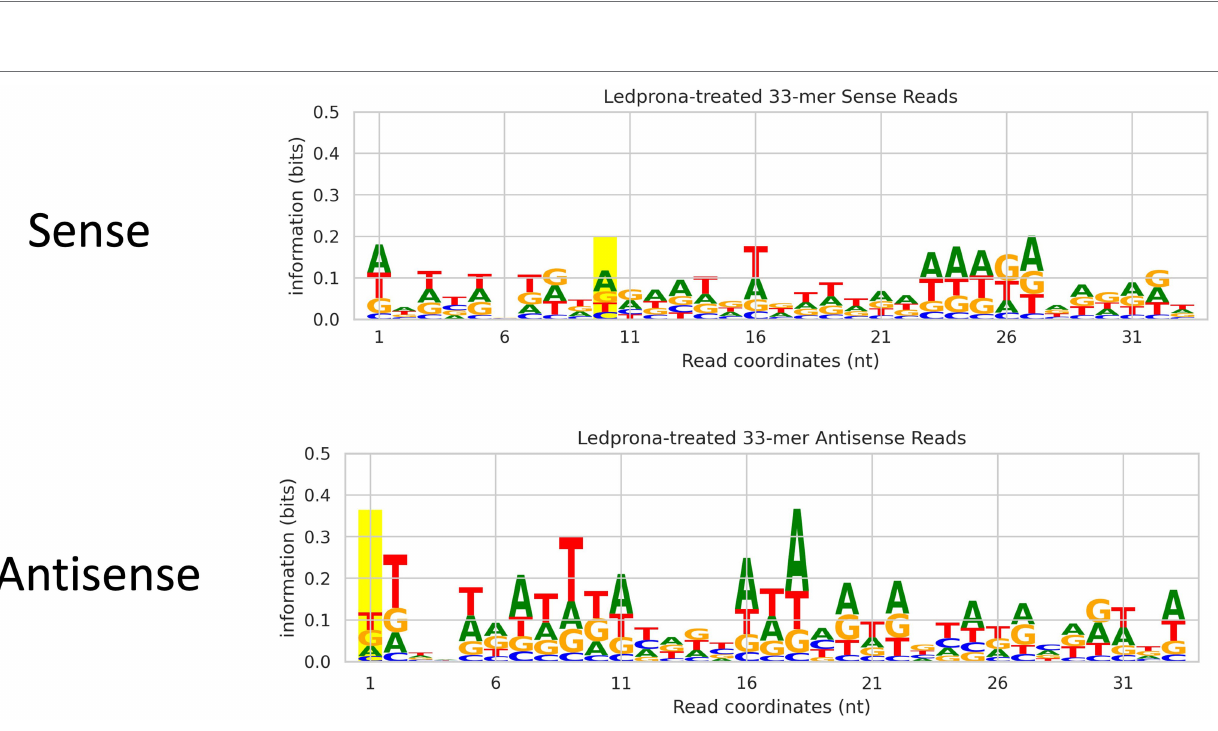
FIGURE 4 | Sequence logo image of 33 nt sequences produced in response to Ledprona treatment to check for ping-pong-derived piRNAs. The top panel shows the sense sequence, and the bottom panel shows the antisense. Position 1 and 10 are highlighted. Y-axis is amount of information (and thus, confidence) for a particular base at a particular position (x-axis). No conclusive signature with high information was